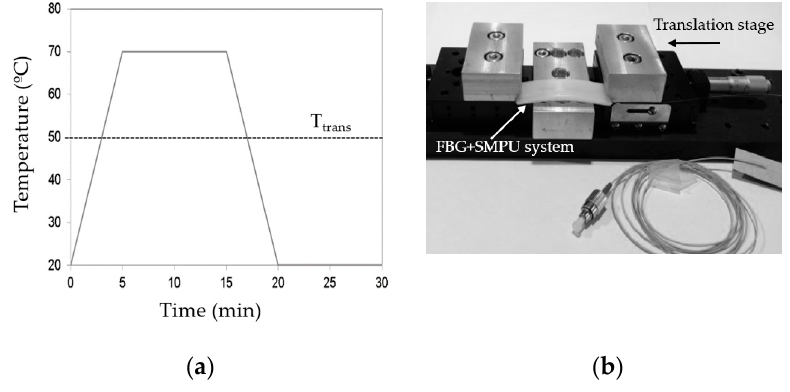
Figure 4. ( a ) Applied shape memory cycle; ( b ) Experimental setup implemented to apply the axial strain to the SMPU.